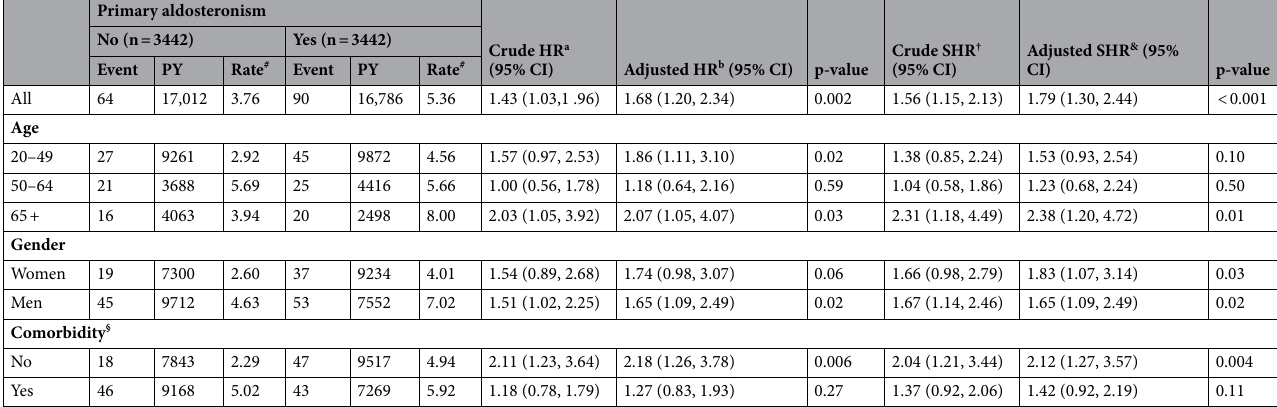
Table 2. Comparison of bladder stone risk in incidence densities, hazard ratio, and sub-hazard ratio in a competing risk (death) model between patients with and without PA stratified by demographic characteristics and comorbidity. Rate # , incidence rate, per 1000 person-years. Crude HR a , relative hazard ratio. Adjusted HR b , adjusted hazard ratio, was calculated by Cox model and adjusted for age, sex, frequency of medical visits, and comorbidities of hypertension, diabetes, hyperlipidemia, gout, urinary tract infection, obesity, chronic kidney disease, fracture, and hematuria. Crude SHR † , relative sub-hazard ratio. Adjusted SHR & , adjusted sub-hazard ratio, was calculated by competing risk (death) model and adjusted for age, sex, frequency of medical visits, and comorbidities of hypertension, diabetes, hyperlipidemia, gout, urinary tract infection, obesity, chronic kidney disease, fracture, and hematuria. Comorbidity § : Patients with any one of the comorbidities (including hypertension, diabetes, hyperlipidemia, gout, urinary tract infection, obesity, chronic kidney disease, fracture, and hematuria) were classified as the group of comorbidity. CI confidence interval, HR hazard ratio, PY, SHR sub-hazard ratio.